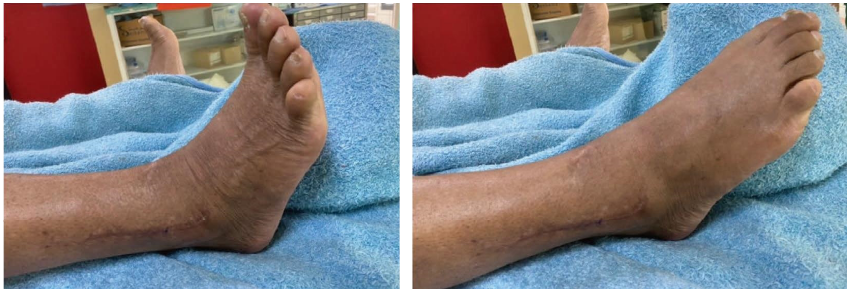
Figure 3: Clinical control of a patient with full recovery of plantar fexion and dorsal fexion of the